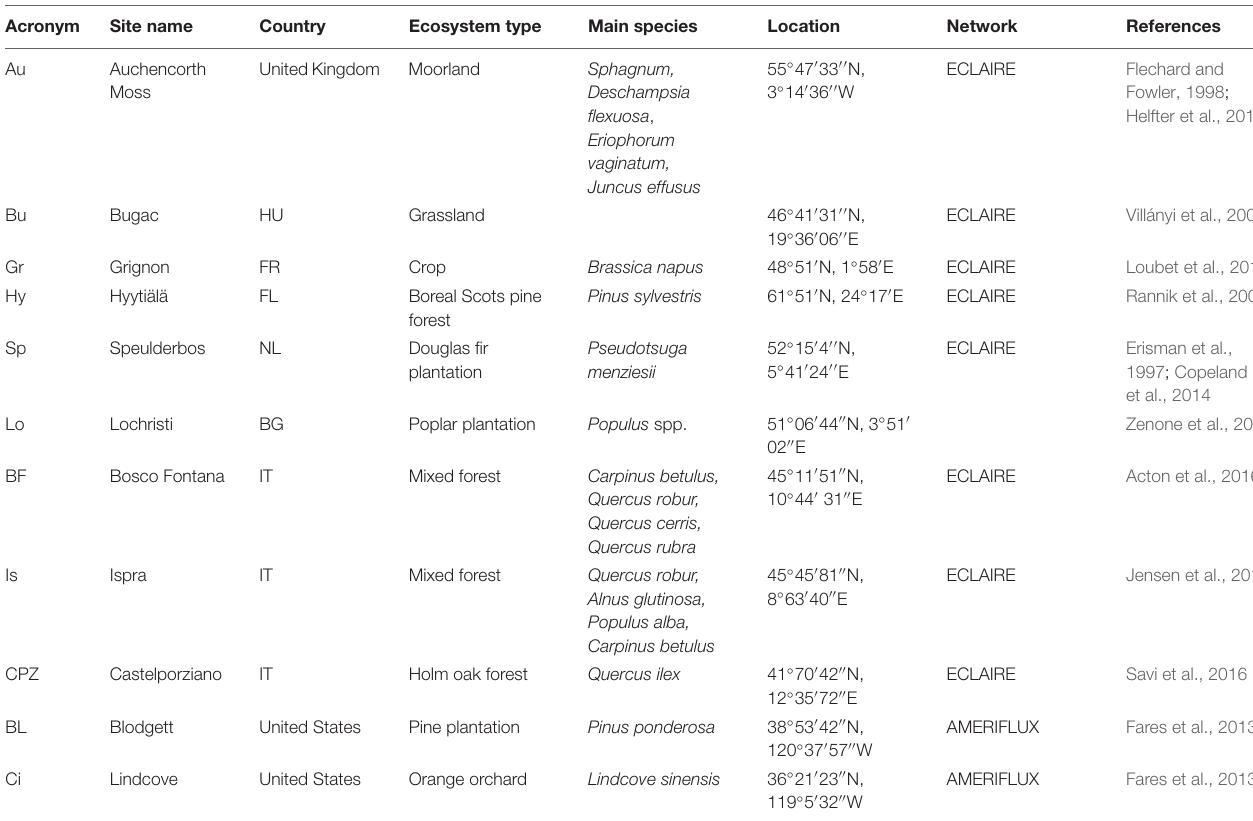
TABLE 1 | Brief description of location and ecosystem type for the study